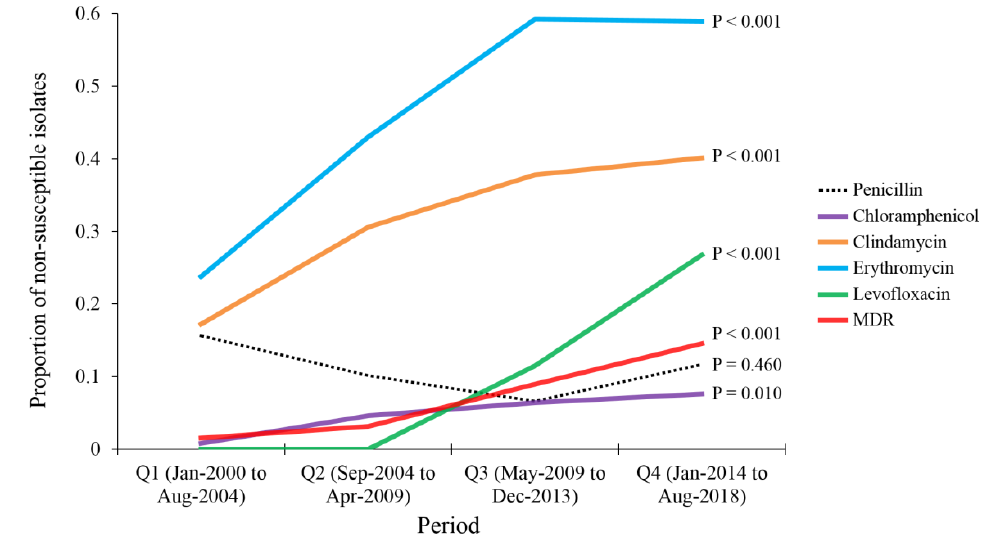
Figure 2. Temporal changes of antimicrobial drug resistance among Streptococcus pneumoniae isolates that were detected at Jordan University Hospital during 2000-2018. Analysis was done by dividing the study period into quarters (Q), each of which represented 56 months: Q1 → January 2000–August 2004, Q2 → September 2004–April 2009, Q3 → May 2009–December 2013 and Q4 → January 2014–August 2018. p values were calculated using linear-by-linear test for association. MDR: multi-drug resistance.